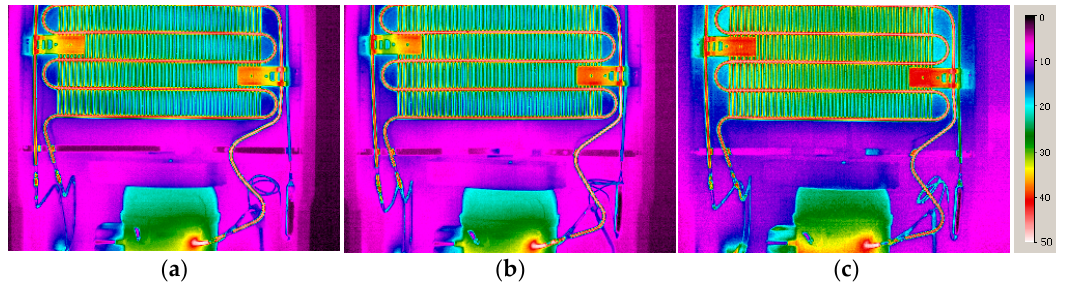
Figure 7. Exemplary infrared images of devices belonging to: ( a ) class G—non-defective devices; ( b ) class E—defective devices with faulty evaporator; ( c ) class B—defective devices with other than evaporator faults.